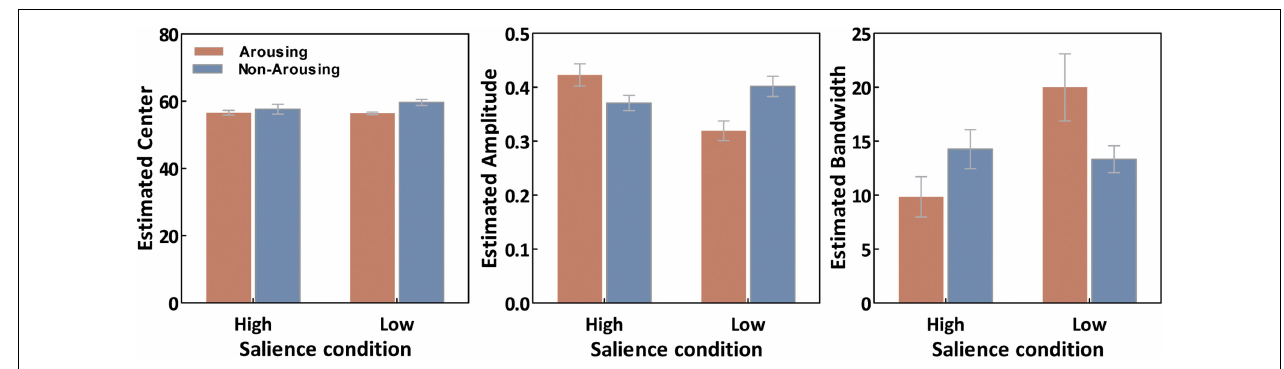
FIGURE 6 |Averaged curve position ( µ ), amplitude ( a ), and bandwidth ( σ ) of tuning curves as a function of conditions. Error bars represent